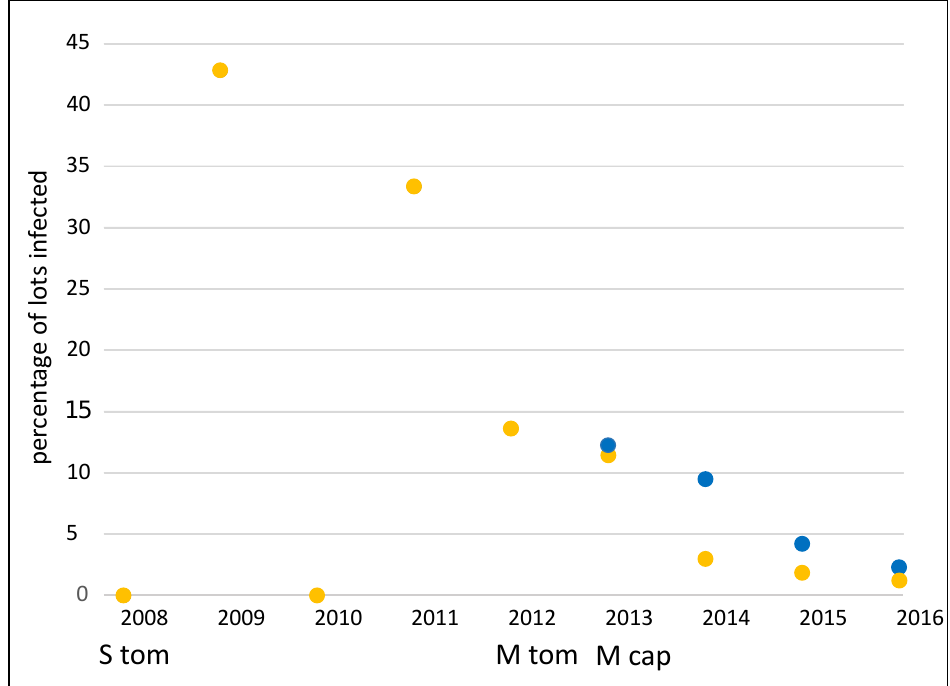
Figure 2. Proportions of tested capsicum and tomato lots (blue and yellow symbols respectively) found to be infected each year. Testing of tomato seed for PSTVd started in 2008 (S tom). Testing of tomato seed imports became mandatory in 2012 (M tom). Testing of capsicum seed was introduced in 2013 and was mandatory from the start (M